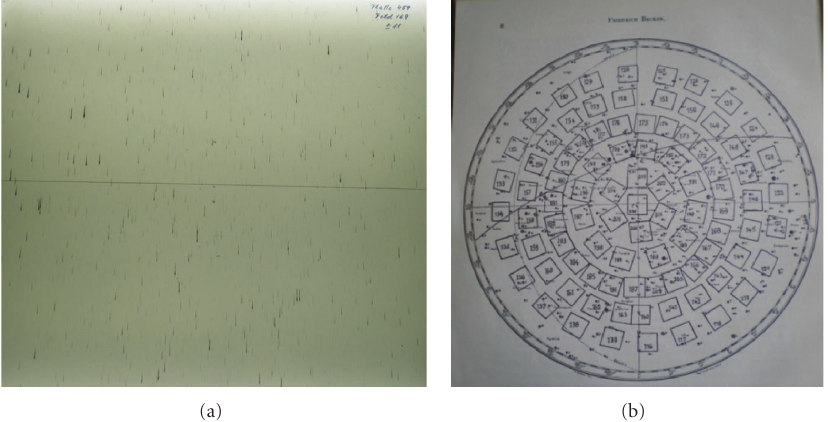
Figure 7: Bolivia Expedition spectral plates (a) and the southern sky coverage of the Bolivia Expedition spectral plates (b).